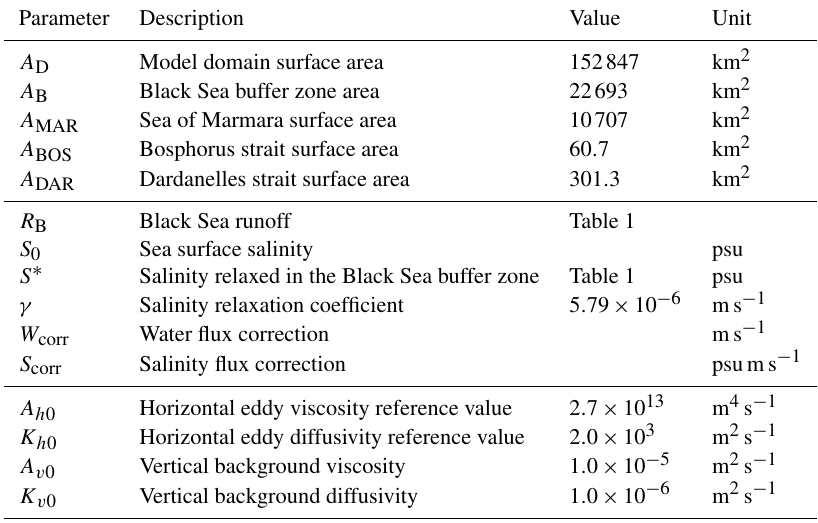
Table A1. Parameters used in the model equations, surface boundary conditions and budget